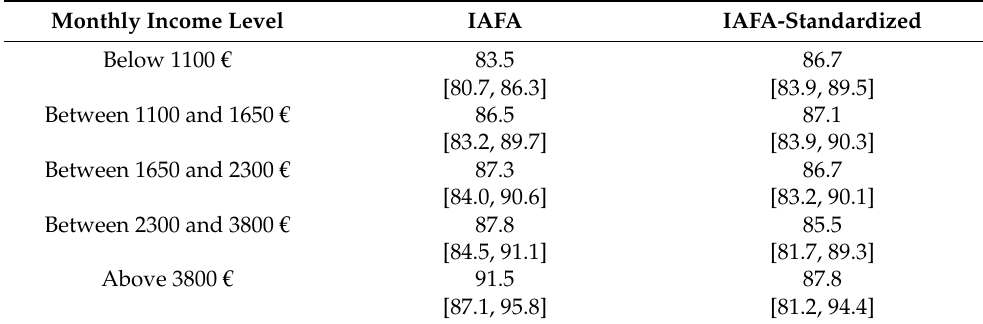
Table 6. IAFA, standardized IAFA and 95% confidence interval (in parentheses below) by monthly income